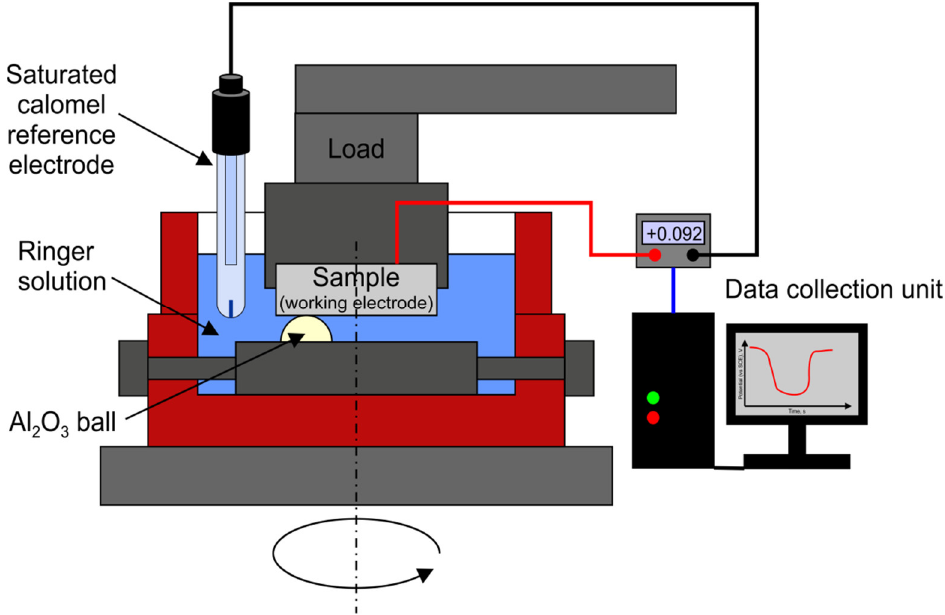
Figure 2. Schematic of the tribological device with parallel corrosion potential measurement during wear tests of the titanium alloy in sliding contact with a ball.